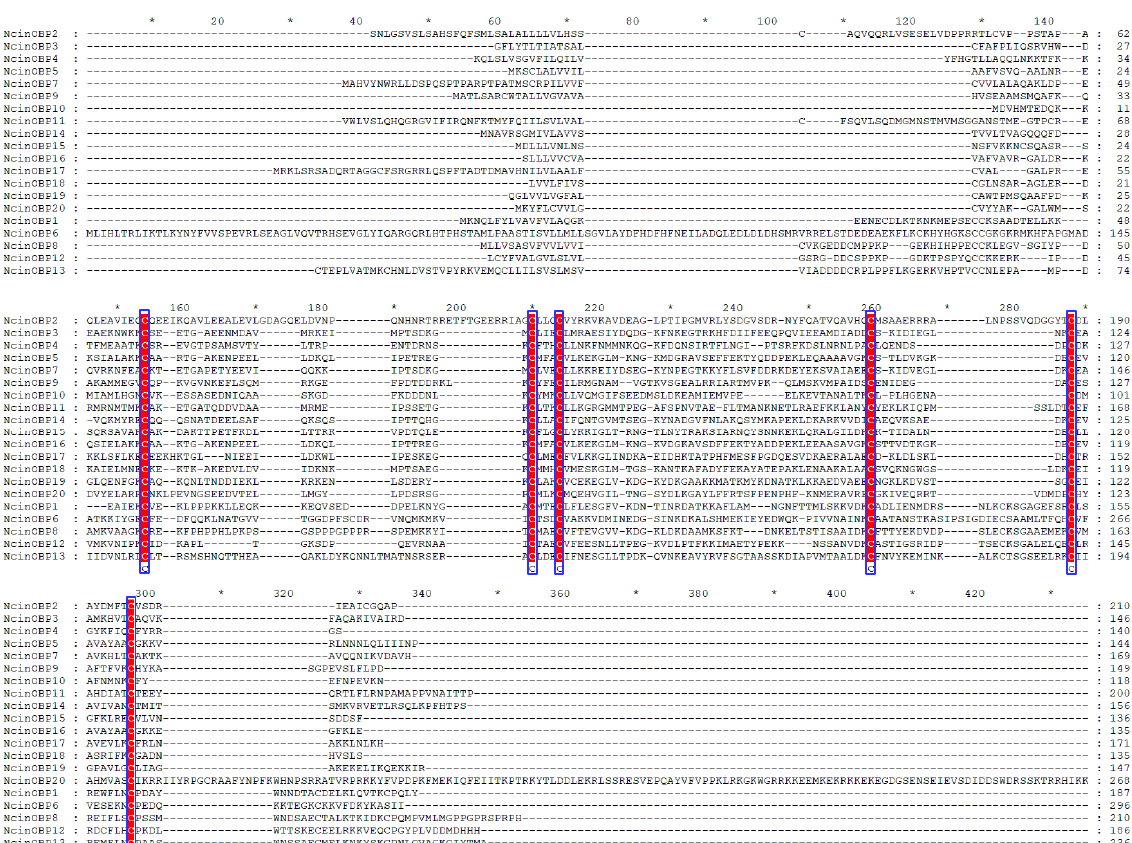
Figure 1. Sequence alignment of N. cincticeps OBPs. Sequences were aligned using the MEGA 6.0 and were presented using GeneDoc software (LynnonBiosoft, San Ramon, CA, USA). * indicates positions which have a single, fully conserved residue. Conserved amino acid residues are indicated by red letters. The six conserved Cys was indicated at the bottom of the alignment with a blue frame. The top 15 in order belonged to the “classic OBP family”, while sort the last five belonged to the “Plus-C OBP family”.